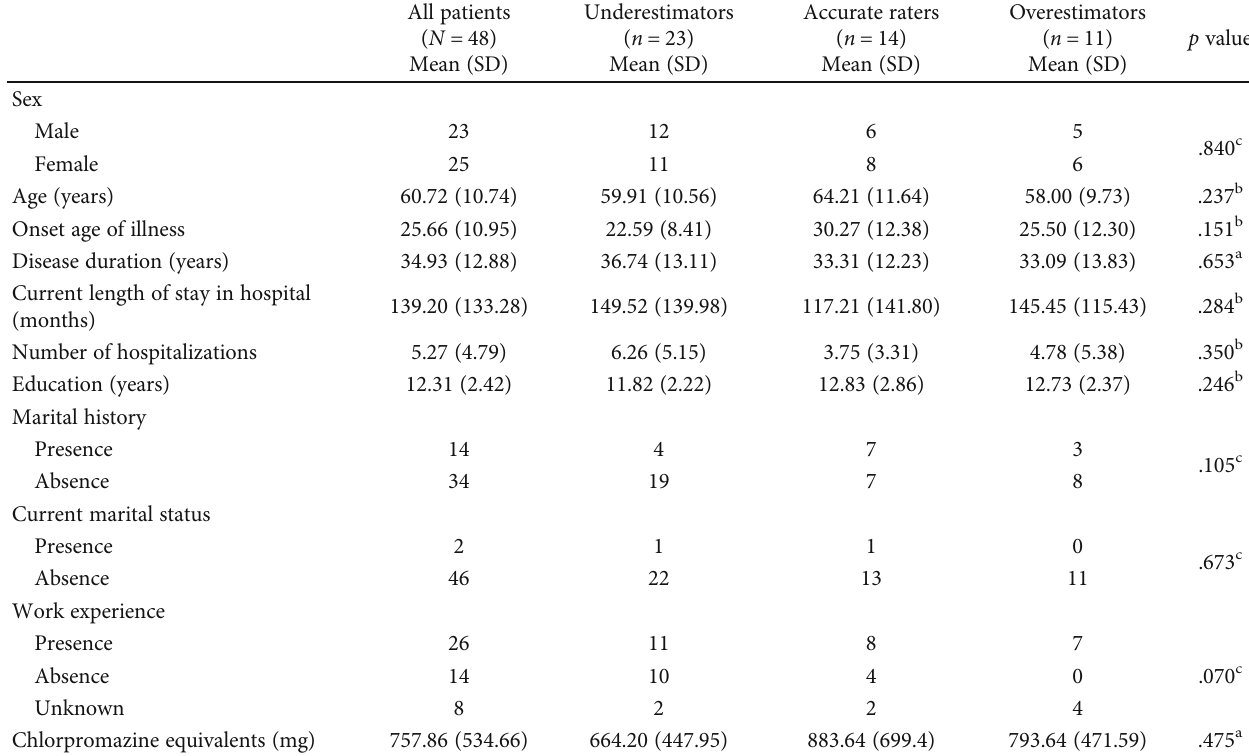
Table 1: Comparison of sociodemographic characteristics between the three groups.